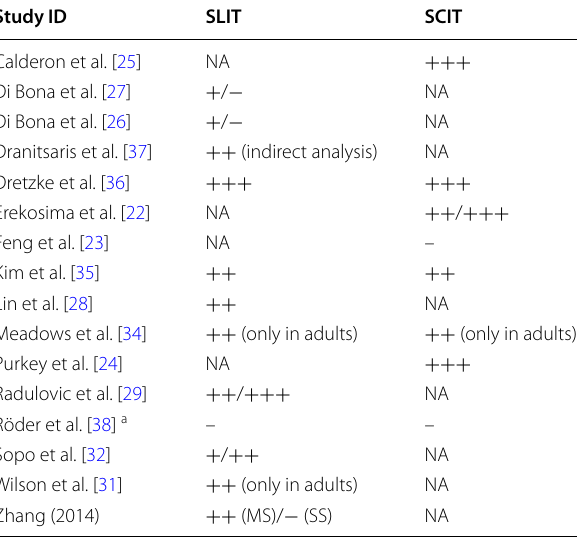
Table 3 Summary of evidence to support the effectiveness of